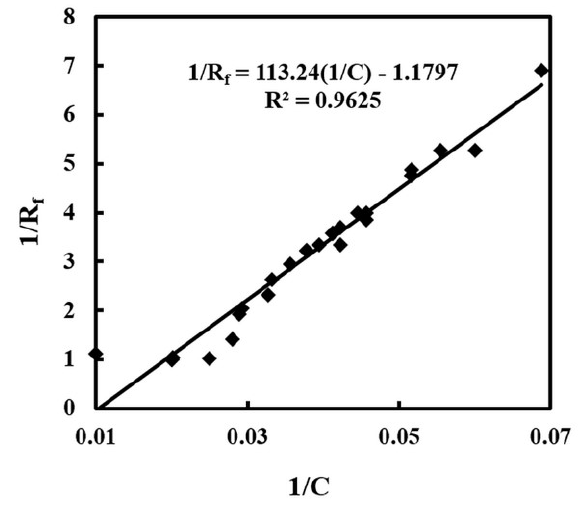
Figure 1: Dependence of the inverse of retardation factor of DPPH •, 1/R , on the inverse of the concentration of acetone, 1/C. f Chromatographic conditions: NP plate, temp. +20 ○ C, saturated chamber.